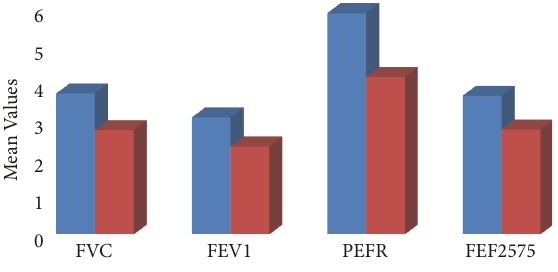
Figure 2: Mean values of pulmonary function tests in hypertensive females (cases) and nonhypertensive females (controls) at Zewditu Memorial Hospital, Addis Ababa, Ethiopia,